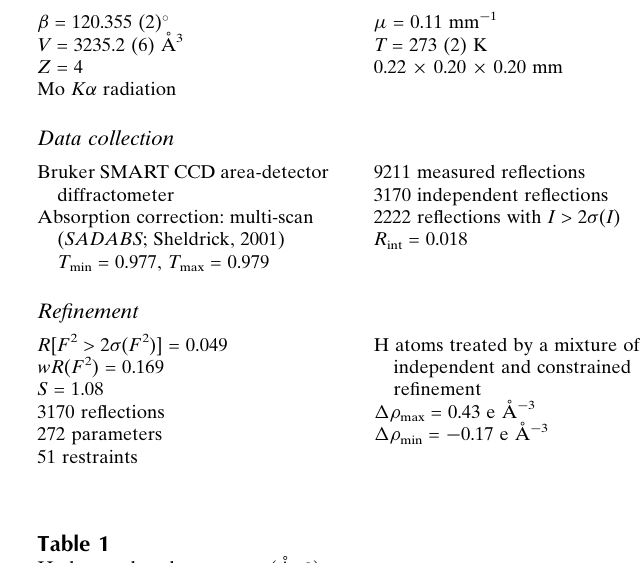
Hydrogen-bond geometry (A˚ , (cid:2)